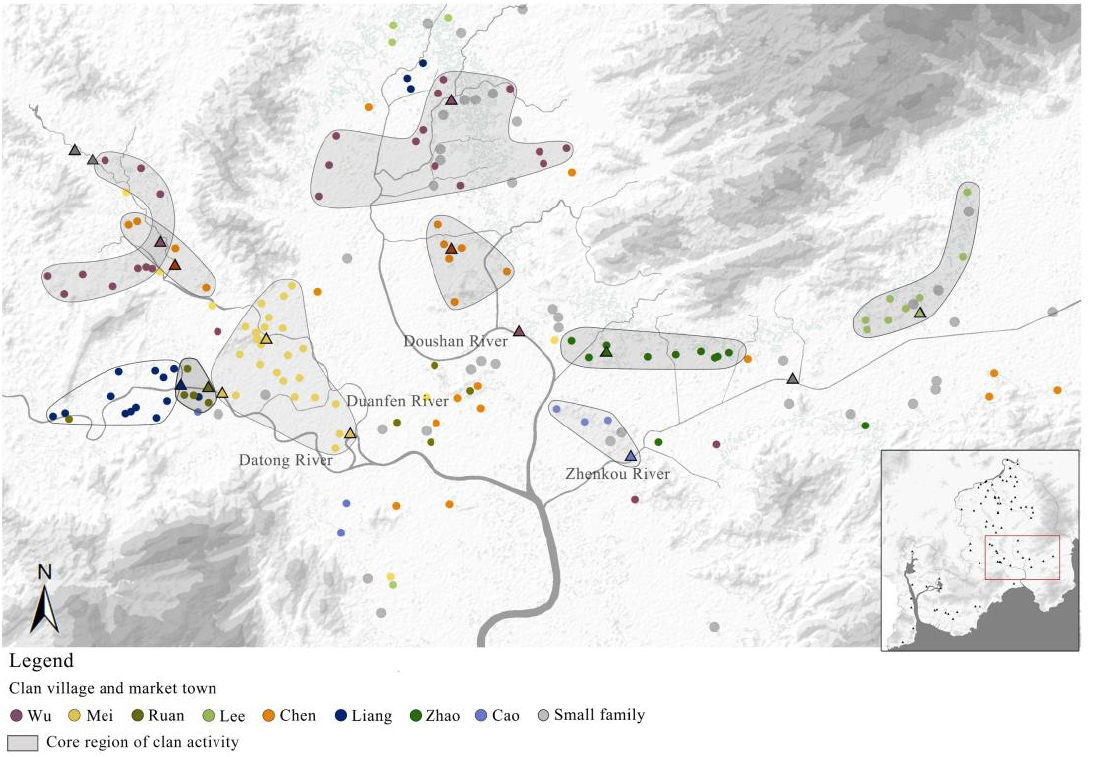
Figure 4. Distribution of clan villages and market towns in the southern area. The triangles of different colors represent different clan market towns, and the dots of different colors represent different clan villages.